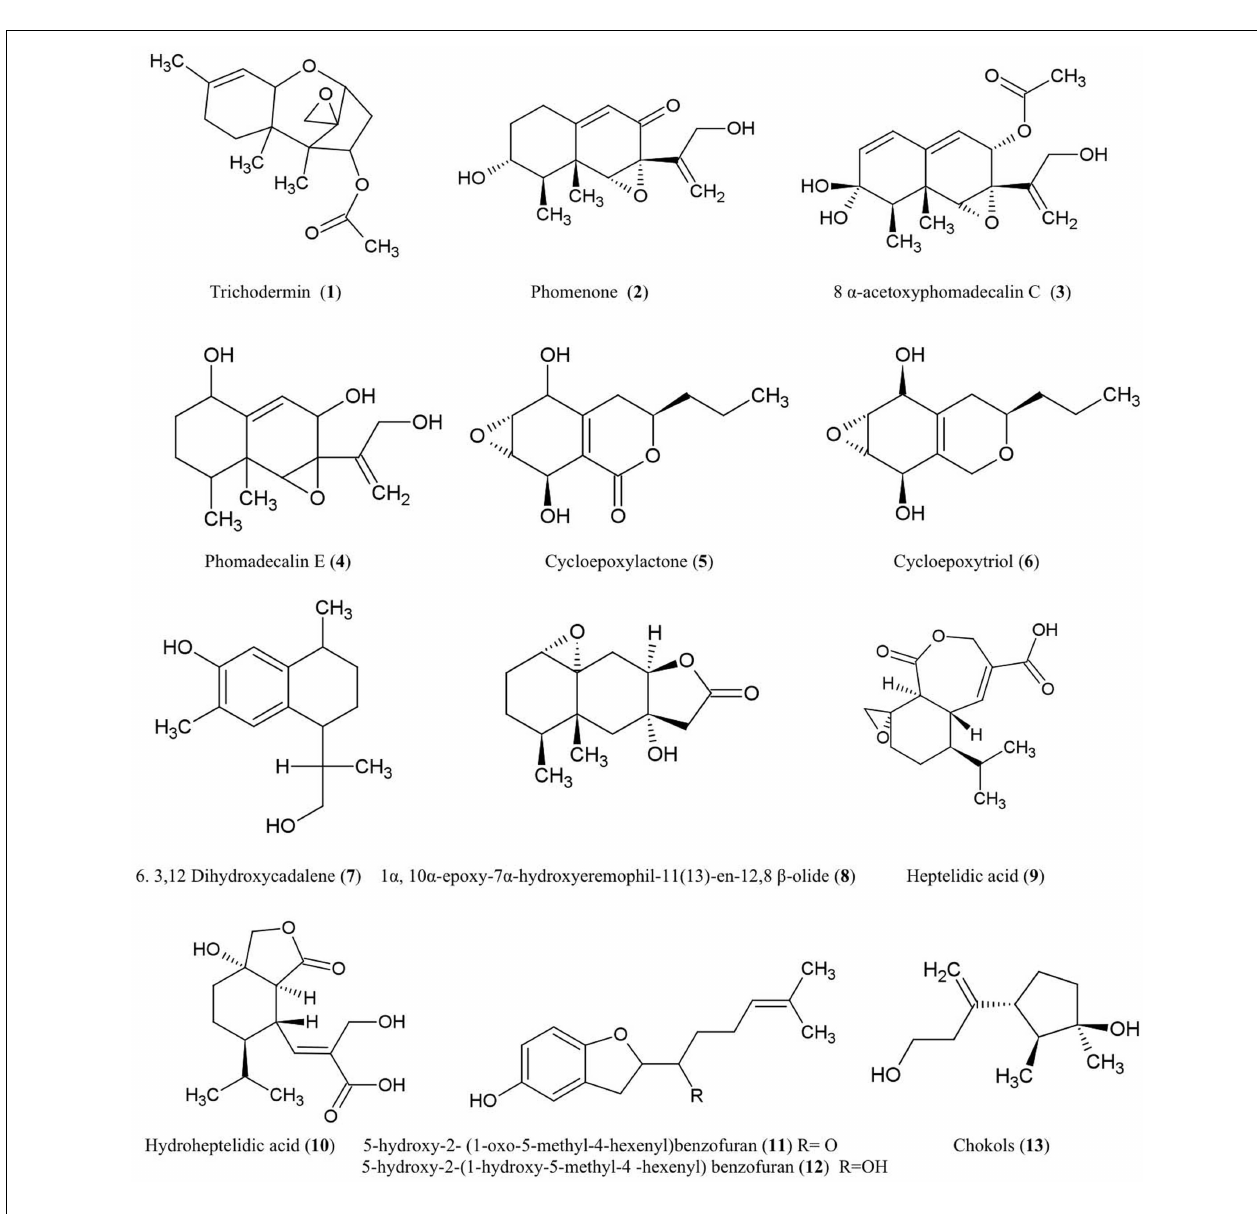
FIGURE 1 | Structures of sesquiterpene derivatives of fungal endophyte origin (1–13).